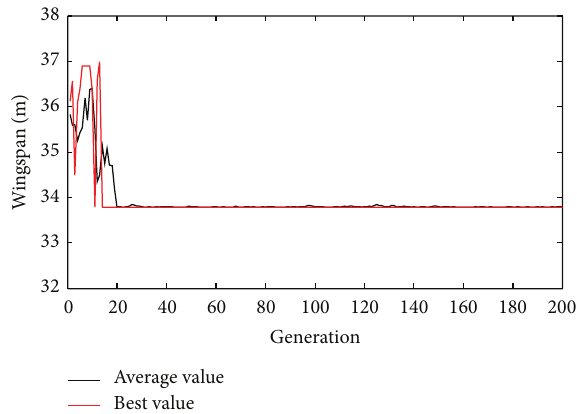
Figure 4: Best and average wingspan (m) versus